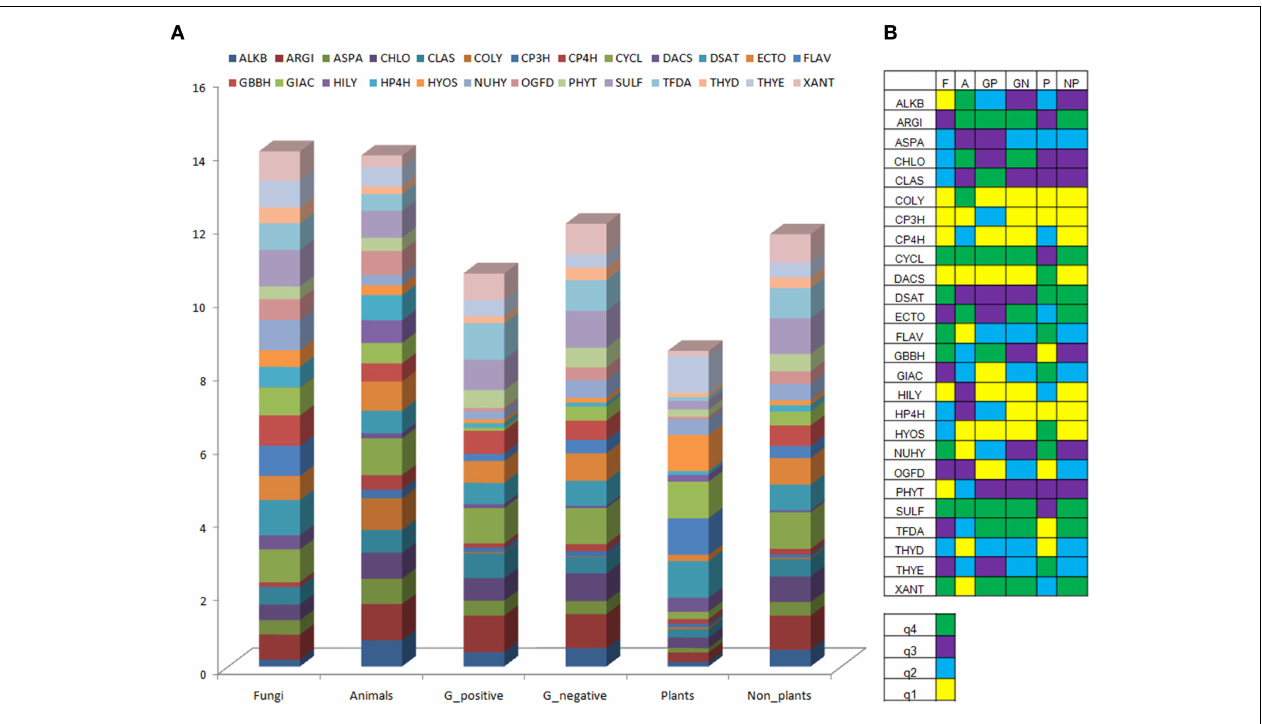
FIGURE 3 | Domain analysis of sequences of DB2OG. (A) Taxonomic spread of catalytic domains in sequences, (B) Quartile representation of domains. Abbreviations: F, fungi; A, animals; GP,